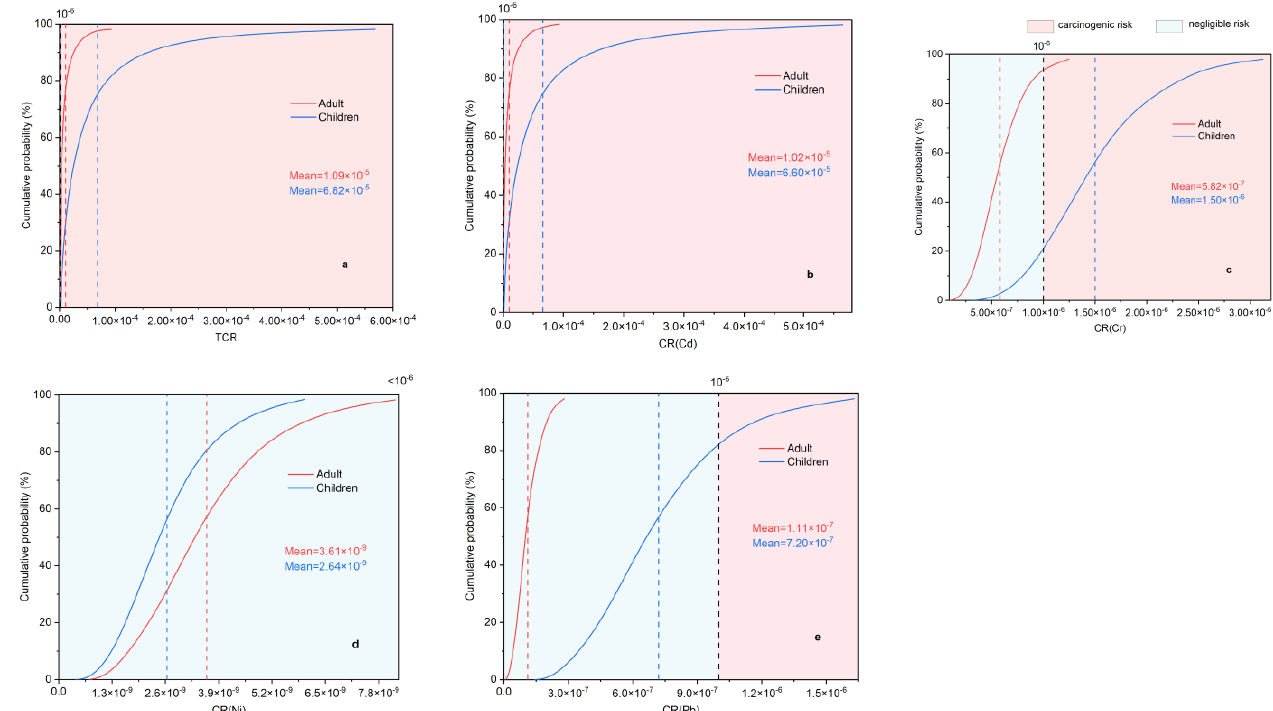
Figure 8. Probability distribution of ( a ) total cancer risk (TCR) and CR indices of ( b ) Cd, ( c ) Cr, ( d ) Ni, and ( e ) Pb. The red, blue, and green vertical dashed lines represent the mean values and the black line represents the acceptable threshold (1 × 10 −6 ).